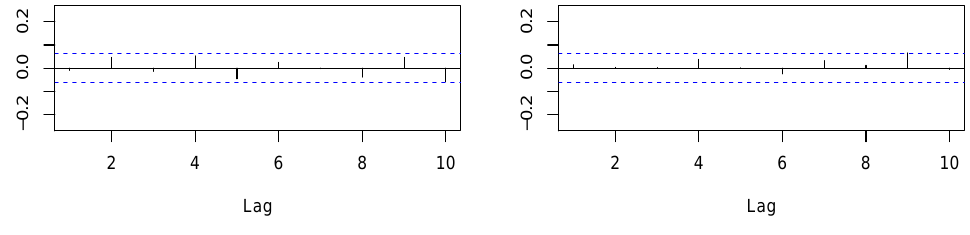
Figure 3. (cid:98) L t , in-sample autocorrelations of HAR residuals ( left ) and their squares ( right ).